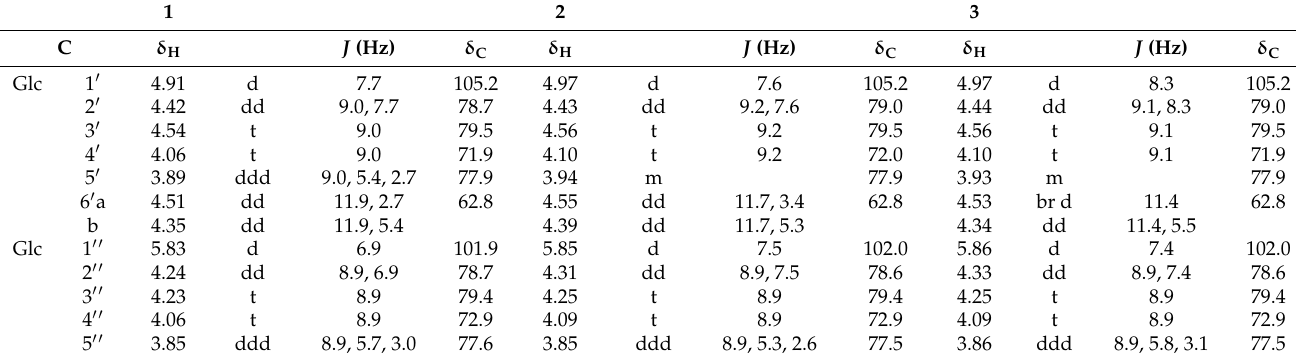
Table 2. 1 H and 13 C NMR (500 and 125 MHz, C 5 D 5 N) spectroscopic assignments of the sugar moieties of 1 – 3